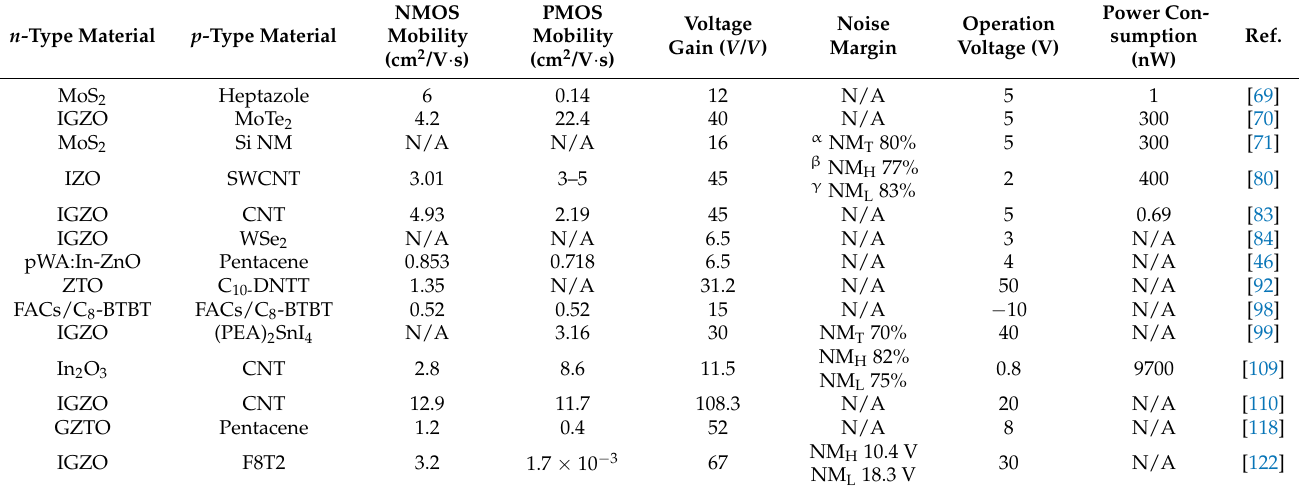
Table 3. Performance comparison of the hybrid complementary inverter.